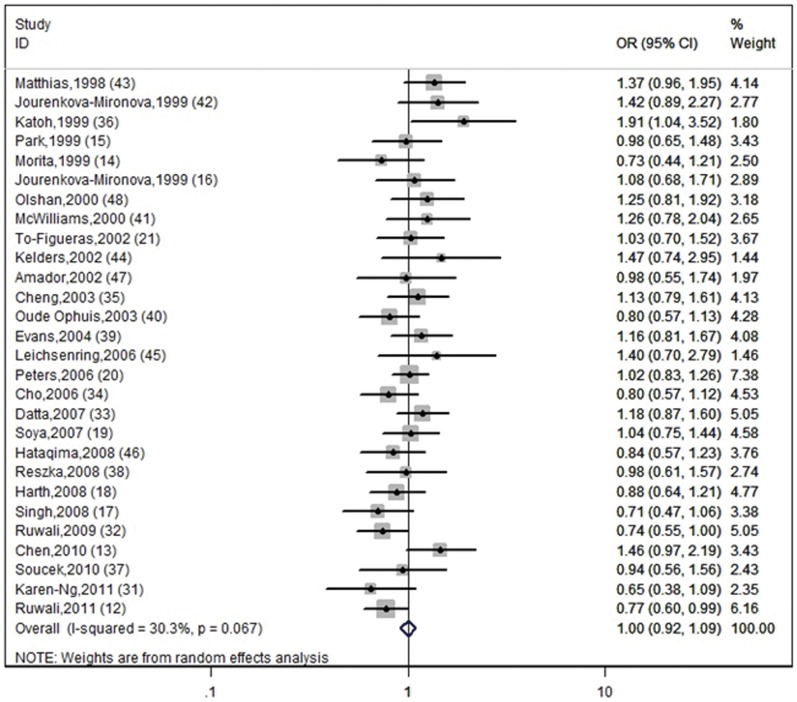
Forest plot with a random-effect model for GSTP1 Ile105Val polymorphism and risk for HNC.The center of each square represents the OR value, the area of each square is proportional to the sample size and thus the weight of the corresponding study, and the horizontal short line indicates the 95% confidence interval. The pooled OR is represented by the diamond. (Test for heterogeneity: chi2 = 38.75, df = 27, p = 0.067. Test for overall effect: z = 0.02, p = 0.984).